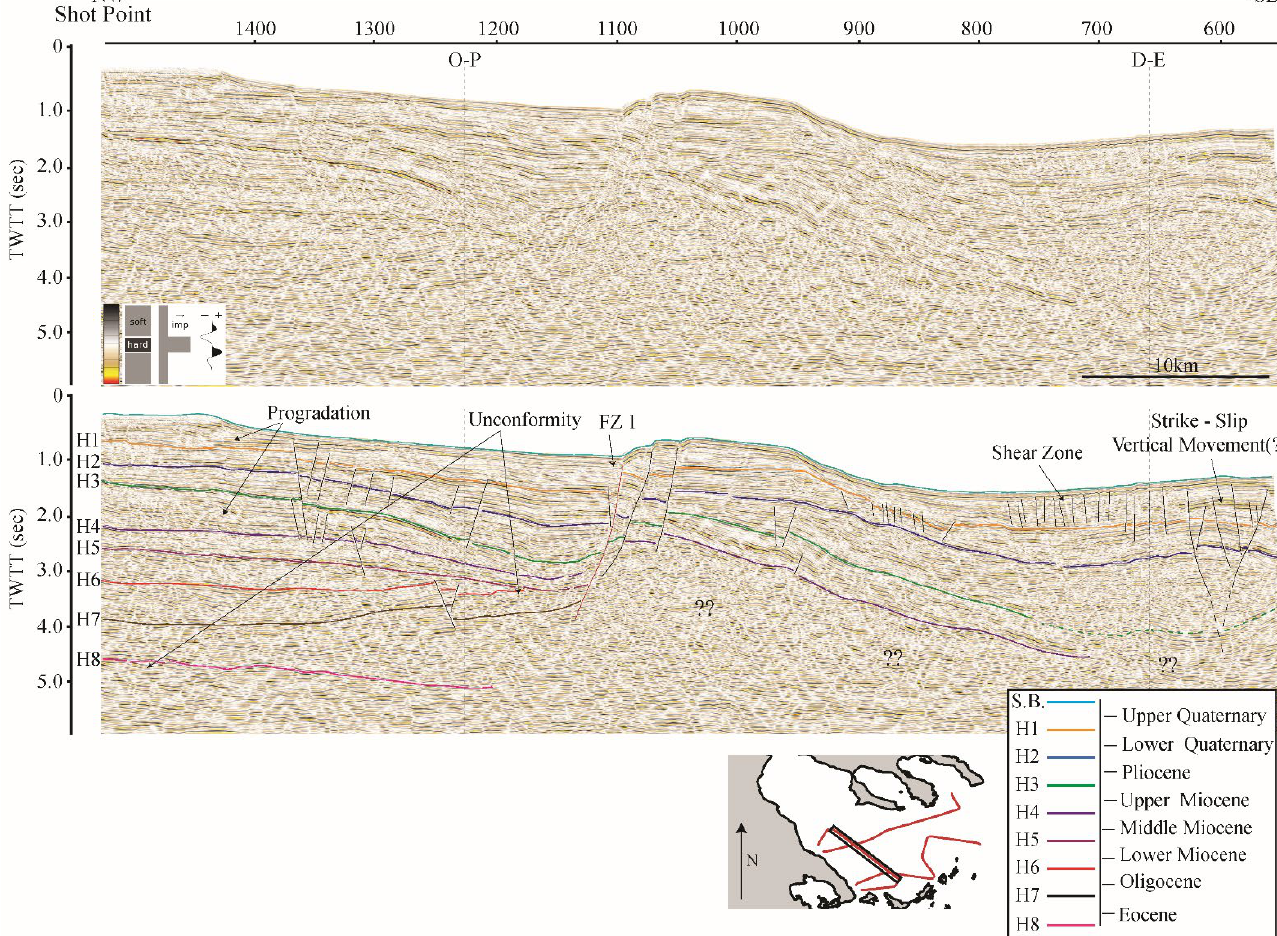
Figure 6. Seismic Line MN. Upper part: un-interpreted regional seismic profile. Lower part: interpreted seismic section with highlighted key horizons and the most prominent tectonic elements.